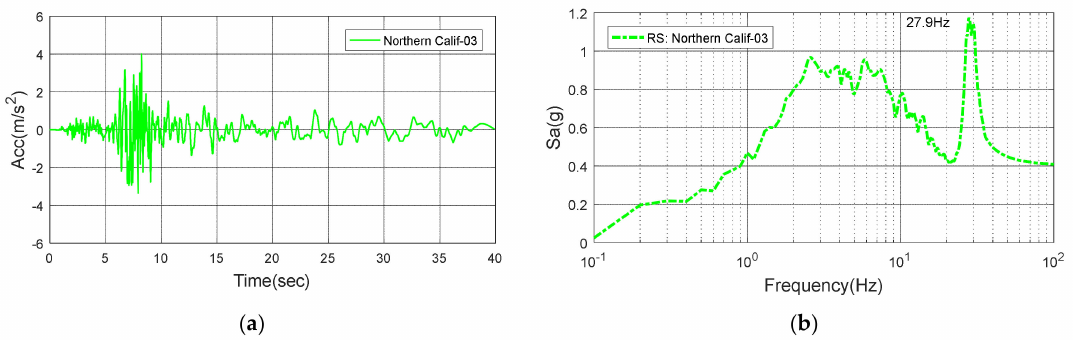
Figure 14. Northern Calif-01: ( a ) Time history; ( b ) Response spectrum.